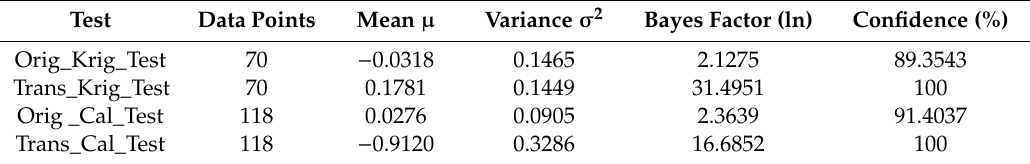
Table 1. Bayesian hypothesis testing for the kriging and calibrated